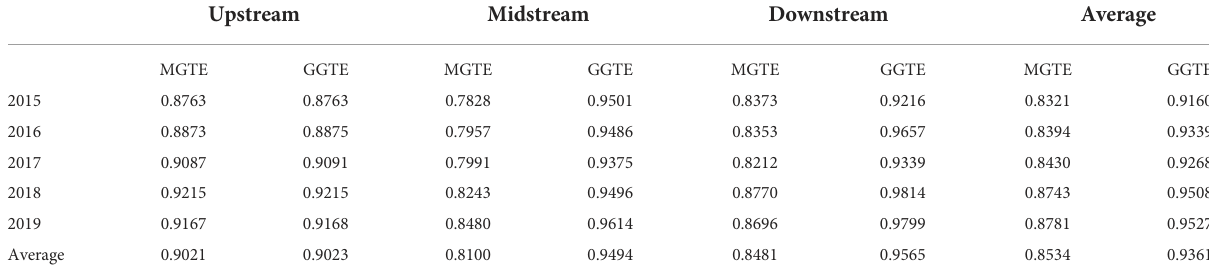
TABLE 3 MGTE and GGTE values of each link of the industrial chain in 2015-2019.